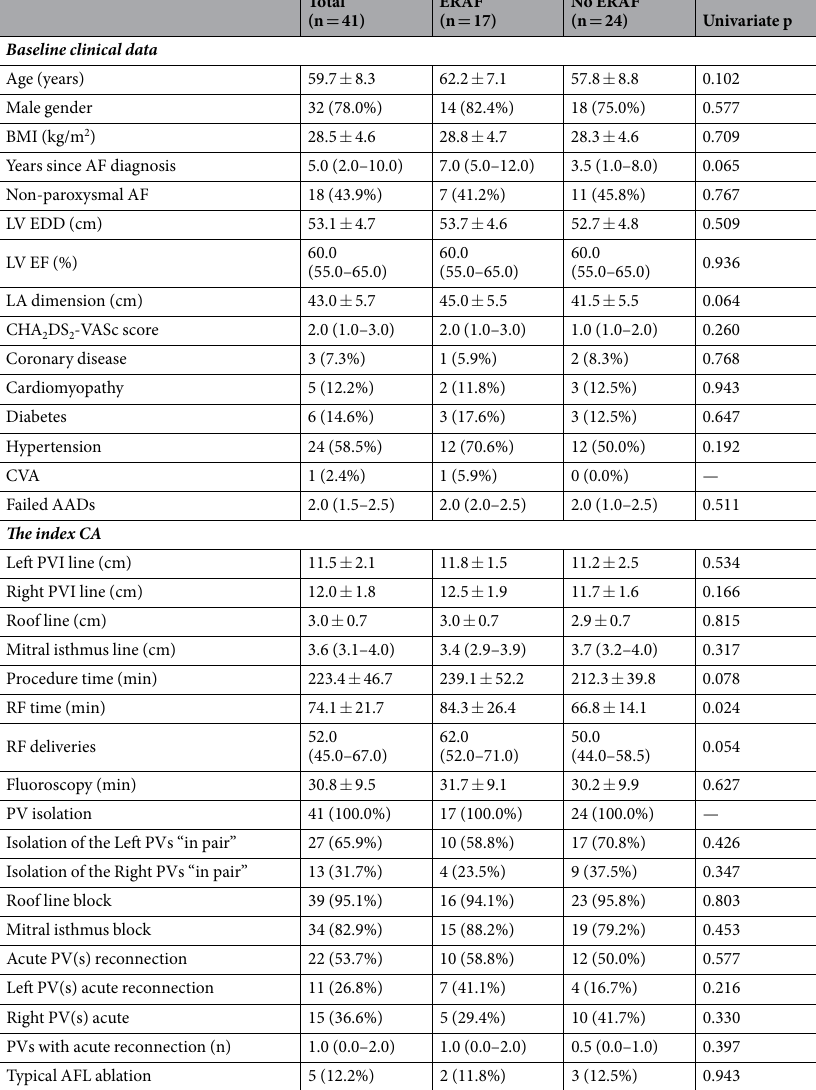
Table 1. Baseline clinical characteristics of the patients and the index ablation data. Data are presented as mean ± standard deviation, median (25th to 75th percentile) or numbers (percentages). ERAF, early recurrence of atrial fibrillation; BMI, body mass index; AF, atrial fibrillation; LV, left ventricle; EDD, end-diastolic dimension; EF, ejection fraction; LA, left atrium; CVA, cerebro-vascular accident; AAD, anti-arrhythmic drug; CA, catheter-ablation; PVI, pulmonary vein isolation; RF, radiofrequency; AFL, atrial